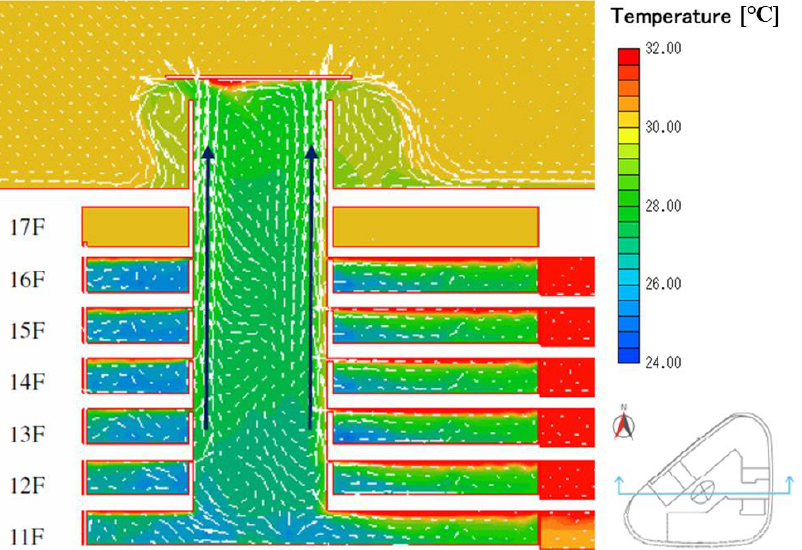
Figure 19. Temperature distribution with 1.9-m handrail and 0.4-m SA height. Table 10. PMV values with various handrail and SA heights.